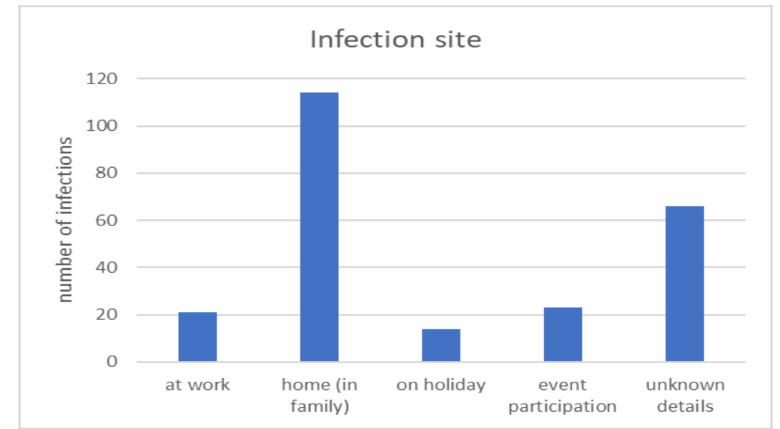
Figure 6. Source of contamination.